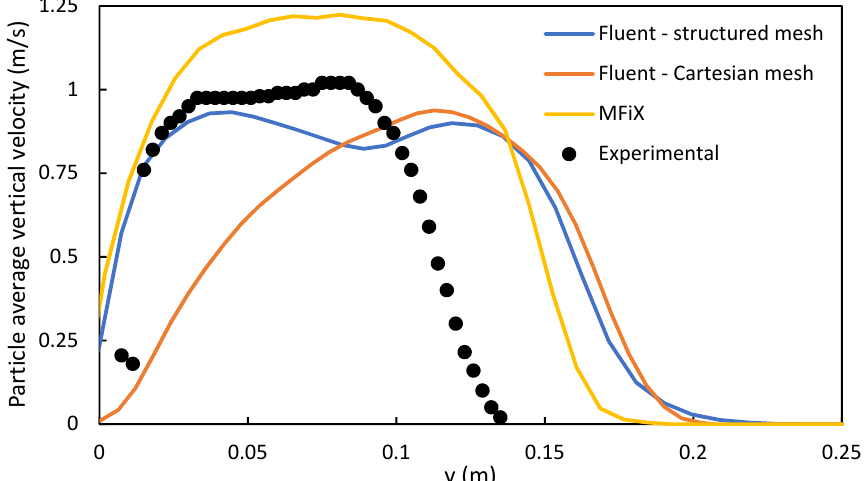
Figure 3. Time-averaged vertical profiles of the particles’ vertical velocity when employing the Gidaspow drag model.